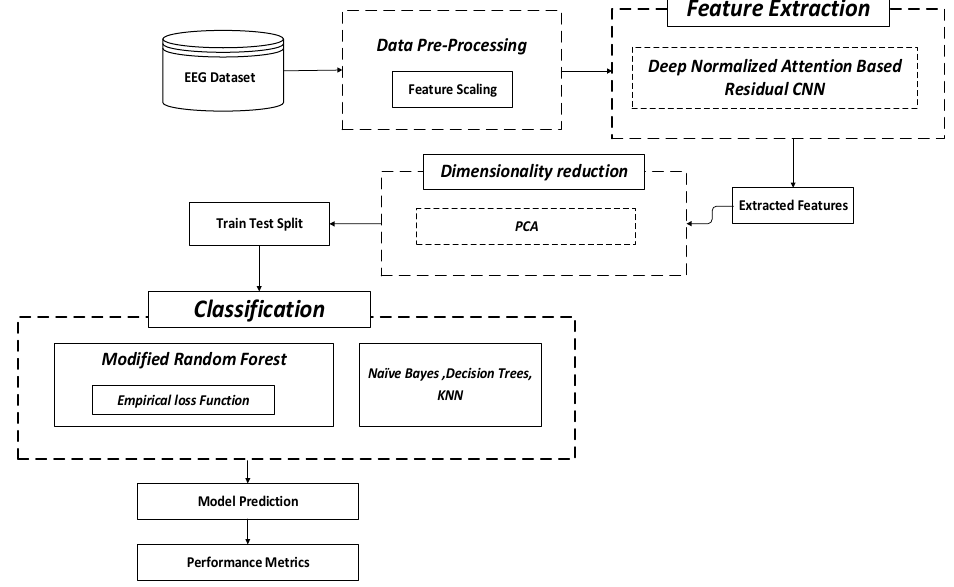
Figure 1. Overall view of the proposed